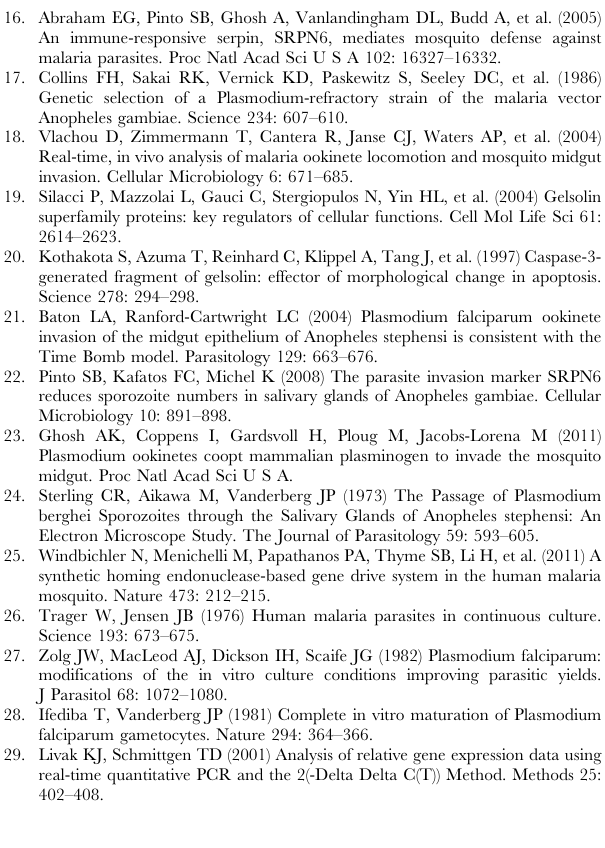
Figure S1 Effect of Plasmodium falciparum salivary gland (SG ) infection on AgESP expression. AgESP mRNA levels in SGs of mosquitoes fed on a healthy (C, control; grey bar) or on a Plasmodium berghei- infected mouse (I, infected; red bar) 18 days post feeding. The unpaired two-tailed t -test was used to compare the different experimental groups (**, P , 0.01). All expression analysis was confirmed in 2–3 independent biological replicates. Figure S2 Effect of AgESP silencing on gelsolin expres- sion in salivary glands (SGs). Effect of LacZ or AgESP dsRNA injection on AgESP (blue bars) and gelsolin (red bars) mRNA levels in SGs. Plasmodium berghei- infected mosquitoes were injected with dsRNA 14 days post feeding, and the SGs were collected 4 days later. The unpaired two-tailed t -test was used